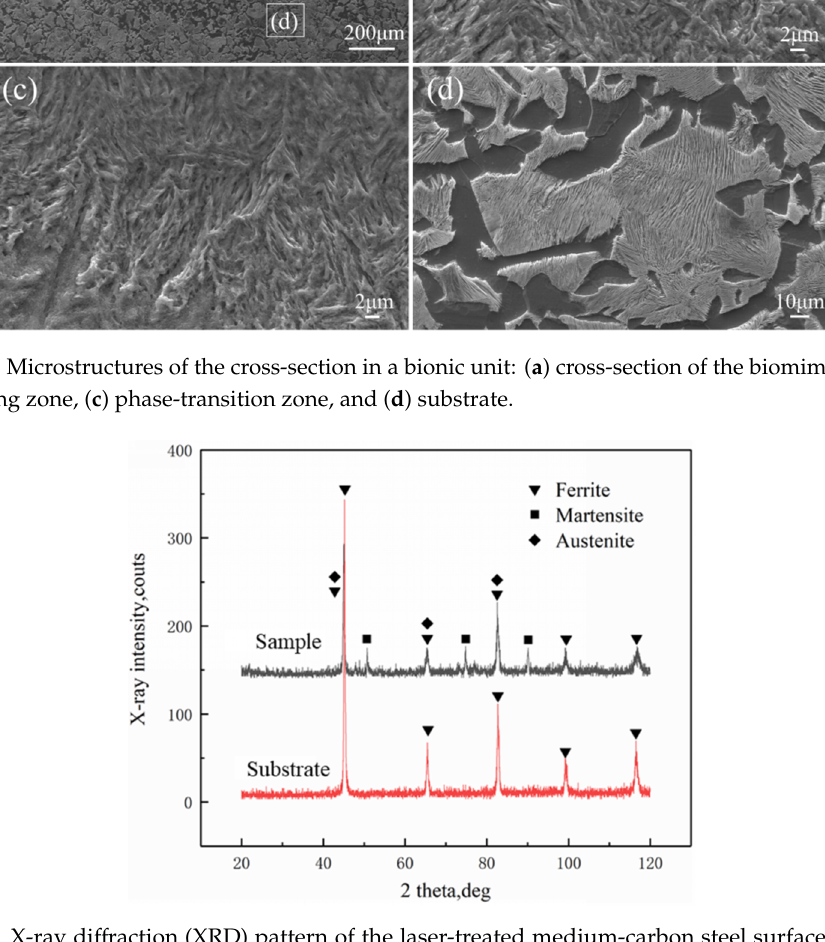
Figure 5. X-ray diffraction (XRD) pattern of the laser-treated medium-carbon steel surface and the untreated surface.